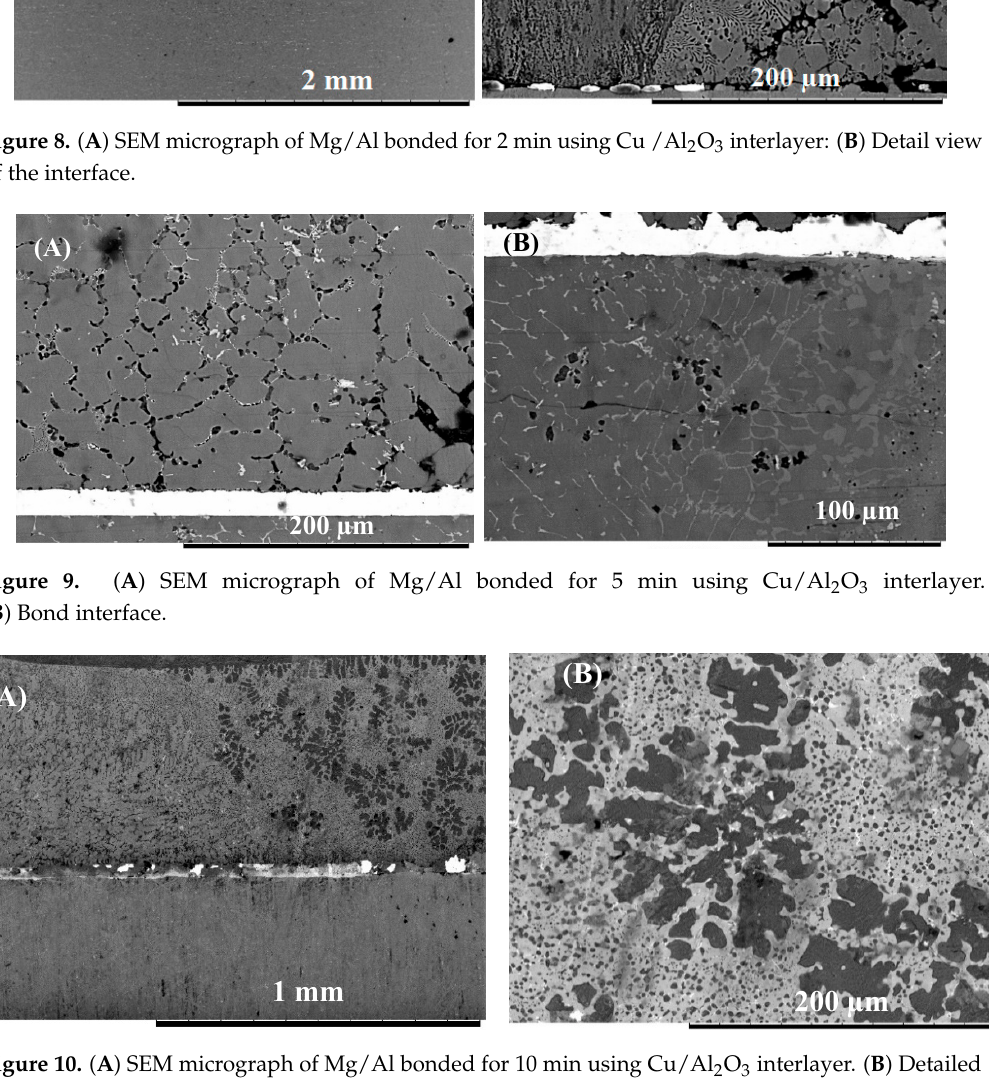
Figure 10. ( A ) SEM micrograph of Mg/Al bonded for 10 min using Cu/Al 2 O 3 interlayer. ( B ) Detailed view of the interface.